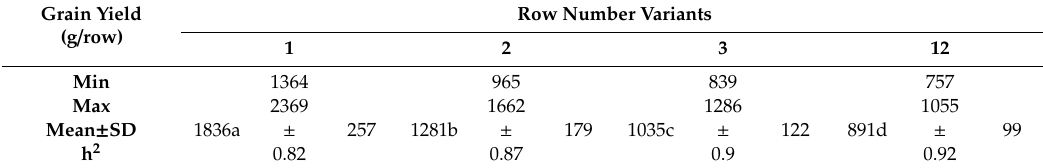
Table 2. Minimum, maximum, mean ± SD, and heritability (h 2 ) of the grain yield in plots with 1, 2, 3 and 12 rows. Mean comparison of plot treatments from Tukey’s HSD test indicated significant di ff erences at p < 0.001.